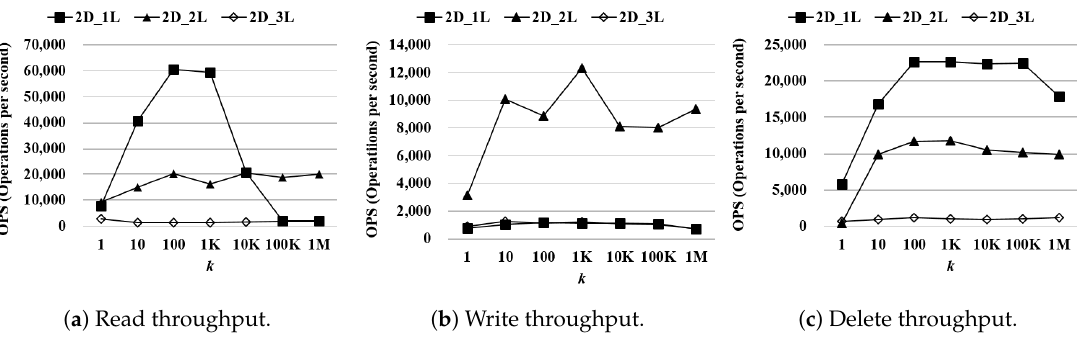
Figure 7. Performance of WR-Store as WR D × WR L is varied. ( a ) Read throughput; ( b ) Write throughput; ( c ) Delete